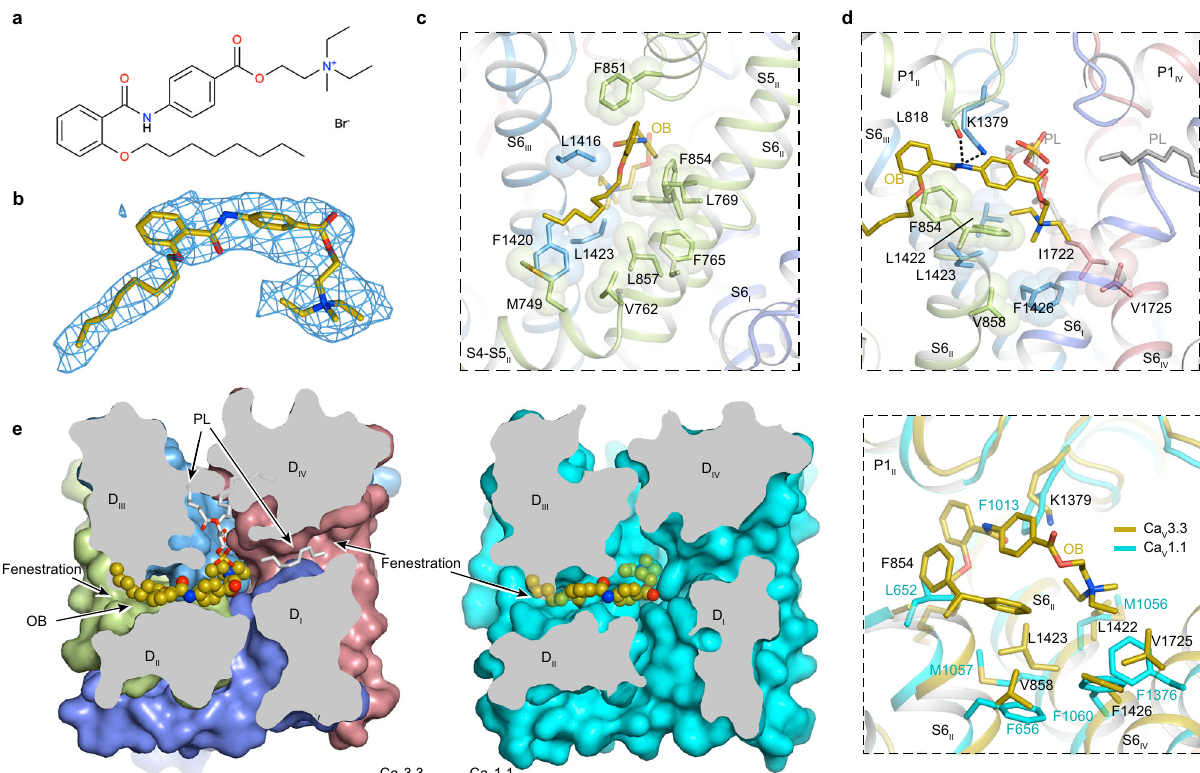
Fig. 4 Structure basis for blockade of Ca V 3.3 by otilonium bromids. a Chemical structures of OB. b The cryo-EM density shown in blue mesh for OB in sticks. c Hydrophobic residues which surrounding the D II -D III fenestration site and penetrated by OB are shown in sticks and overlaid with transparent surfaces viewed in facing the D II -D III fenestration site. OB is shown as brown sticks. d Detailed binding sites of OB in the pore domain. The side chains of key residues are displayed in sticks and overlaid with transparent surfaces. Black dashed lines indicated potential hydrogen bonds. Phospholipids entering through other fenestrations are shown as gray sticks. e Binding site of OB in Ca V 3.3 OB with Ca V 1.1 (PDB ID: 5GJV) (neon green) structures. The domains of Ca V 3.3 OB are colored as D I in purple, D II in green, D III in blue, and D IV in salmon. Extracellular view sectioned below the selectivity fi lter indicates OB penetrates through the D II -D III fenestration site of Ca V 3.3 OB (left panel) and Ca V 1.1(middle panel). Comparison of key residues in the pore domain between Ca V 3.3 OB and Ca V 1.1 is shown in the right